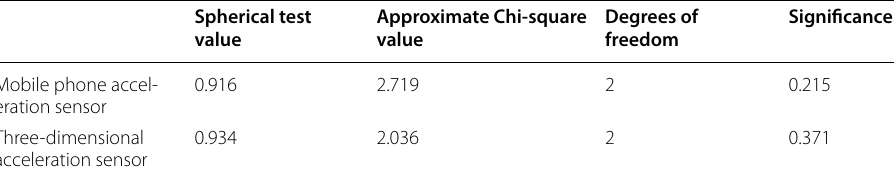
Table 2 Spherical test results of energy consumption (Kcal/min) and METs/min for